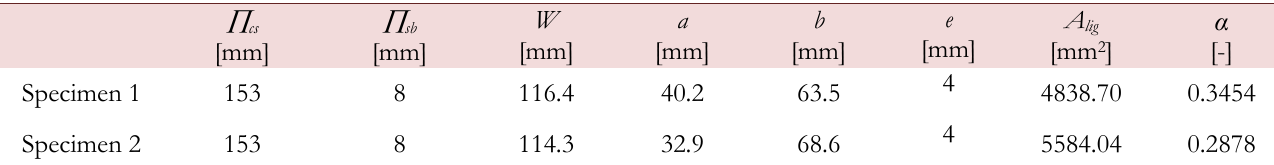
Table 1: Measured dimensions of the two specimens